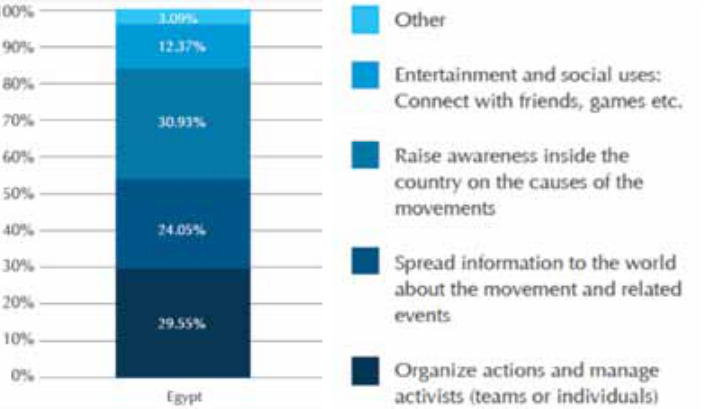
Source : Dubai School of Government